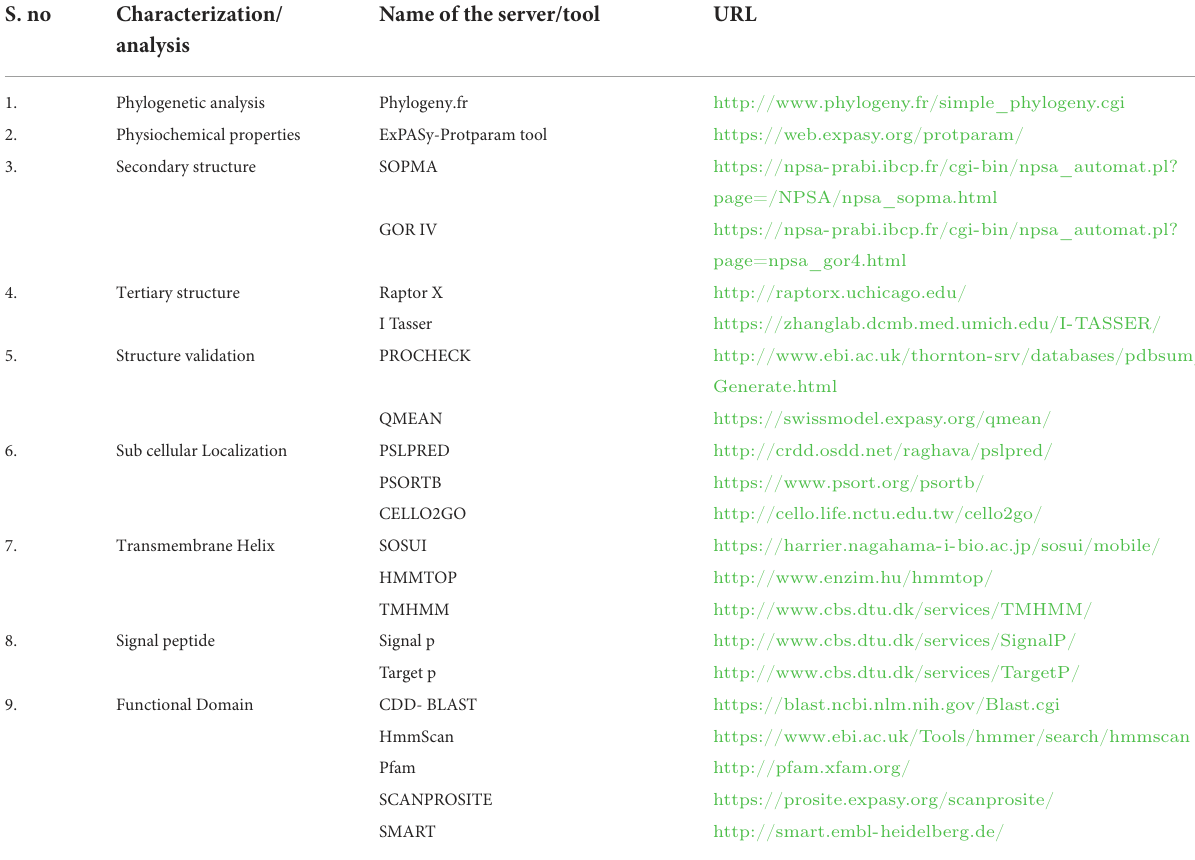
TABLE 2 List of bioinformatics tools and servers employed in the structural and functional analyses of vlhA proteins. S.